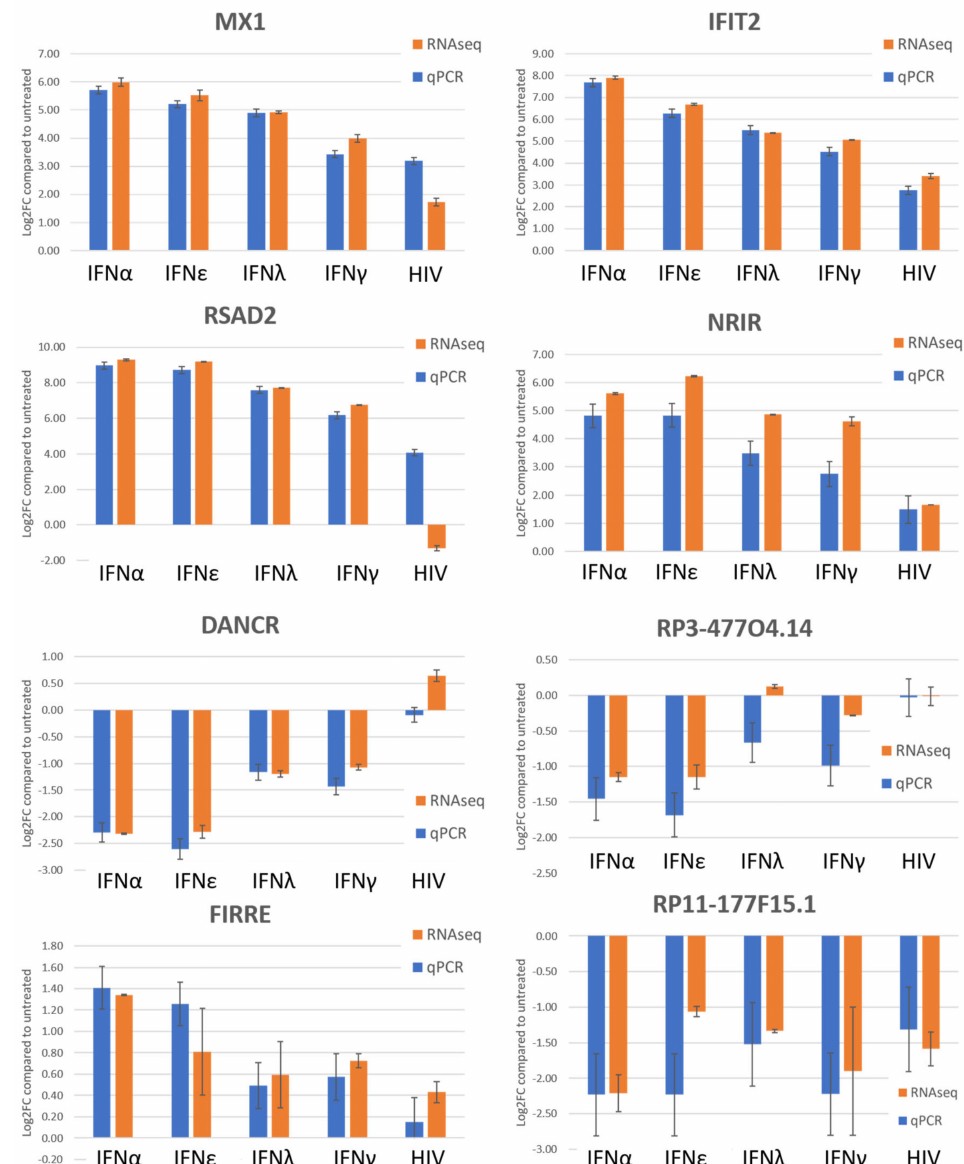
Figure 2. qPCR validation of three mRNAs and five non-coding genes. The RNA from the three replicates for every condition was pooled and the log 2 fold change was determined compared to the untreated condition (n = 2). The data were normalized using three selected reference